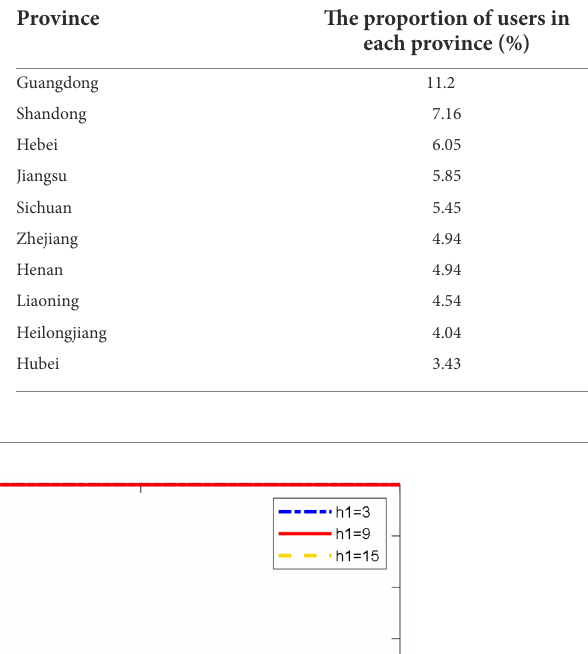
TABLE 2 Proportion of users in each province.